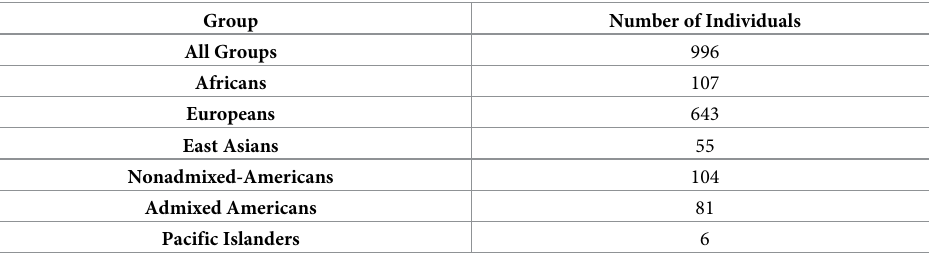
Table 2. Ethnic breakdown of